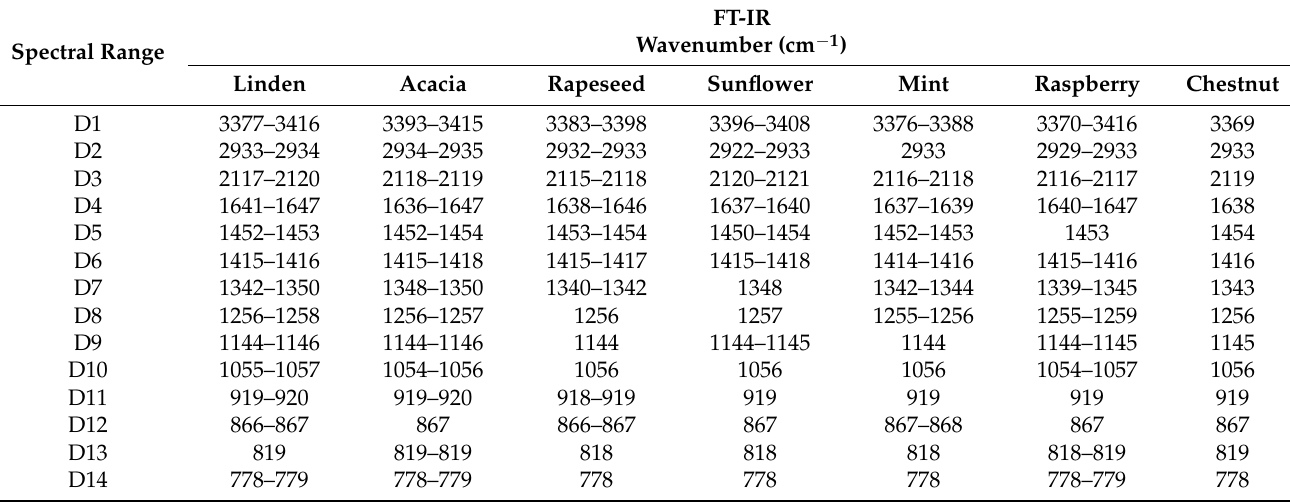
Table 6. Positions of absorption bands for the monofloral honey samples analyzed by